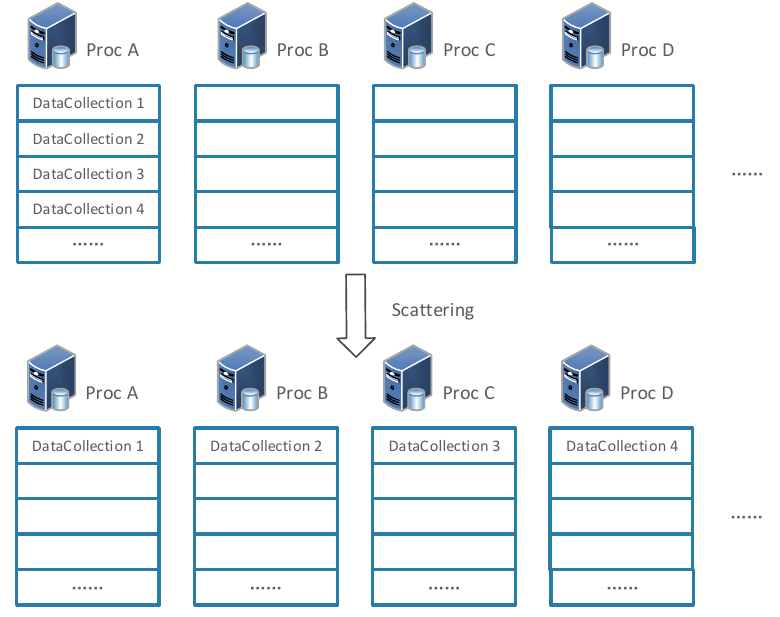
Figure 6. Cluster-based catalogue update.